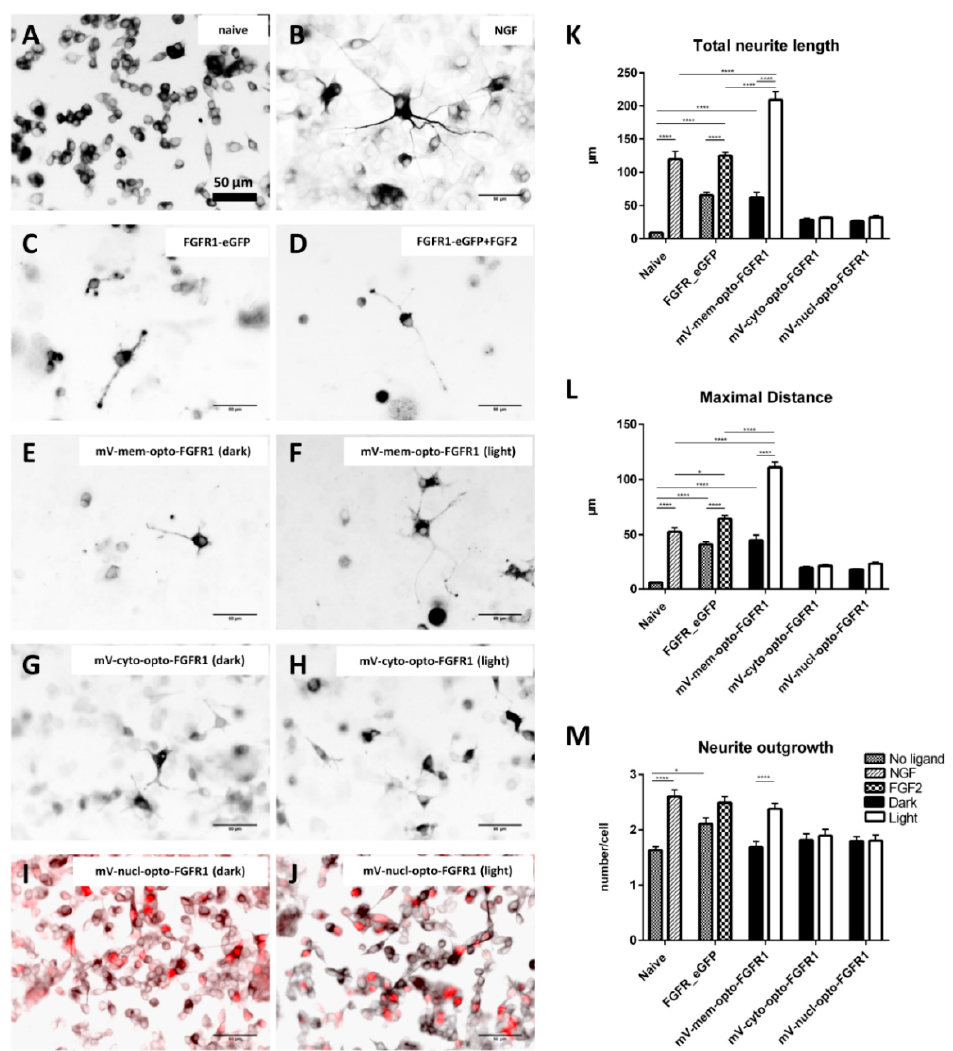
Figure 5. Ligand- and light-induced neurite outgrowth by pheochromocytoma (PC12) cells. ( A – J ) Inverted immunofluorescence images following neuron-specific class III β -tubulin staining to identify neurites (red nuclei in nucl-opto-FGFR1 cells allow identification of transfected cells in I / J ). ( K – M ) Quantification of morphological parameters (total neurite outgrowth, longest process and number of processes per cell; see Figure S1 for details). Results are calculated from three independent experiments and presented as mean ± SEM (50 ≤ n ≥ 100), * p < 0.05, **** p < 0.0001. Scale bars = 50 μ m.